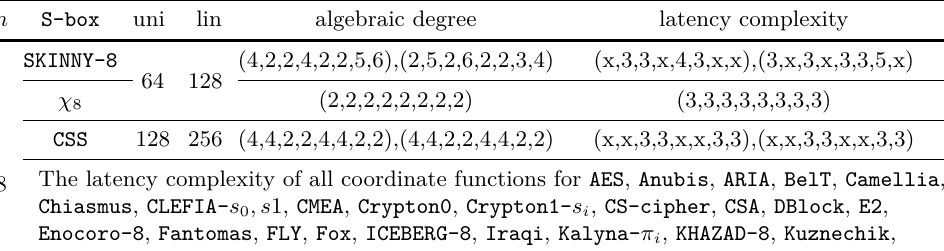
Table 7: Latency Complexity of Known S-boxes (Continued).